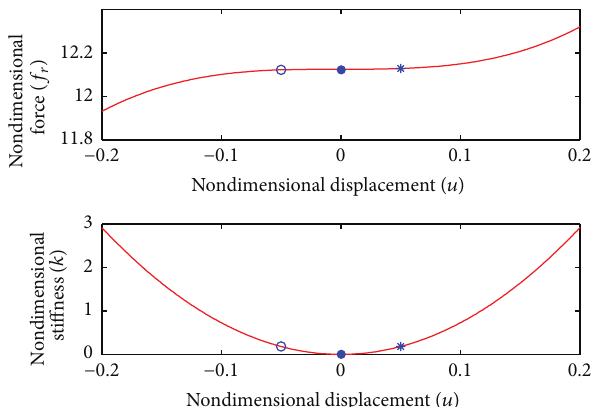
Figure 8: Nondimensional force-displacement and stiffness- displacement curves with the optimal configurative